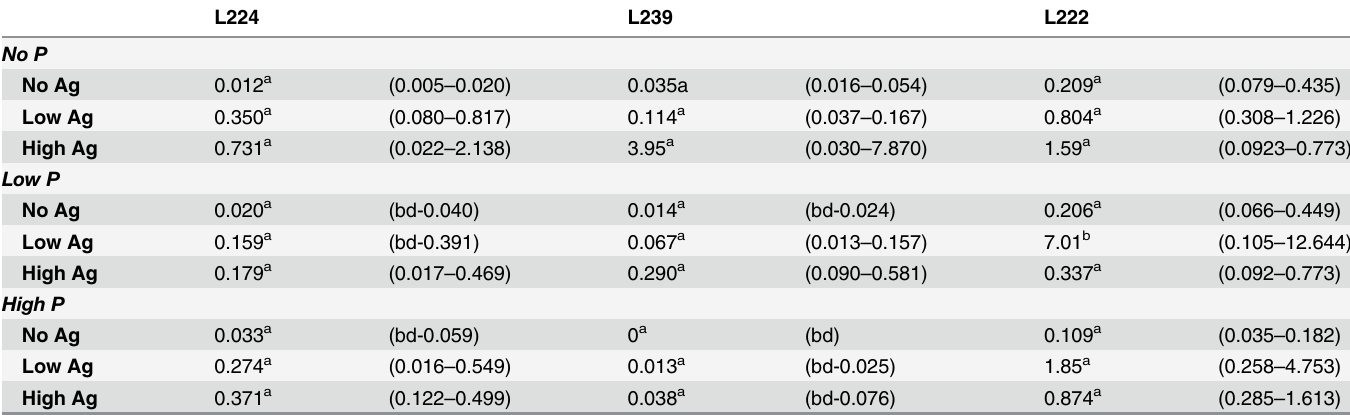
Table 2. Mean (range) Ag content (ng Ag/cm 2 ) of periphyton collected from all three lakes.